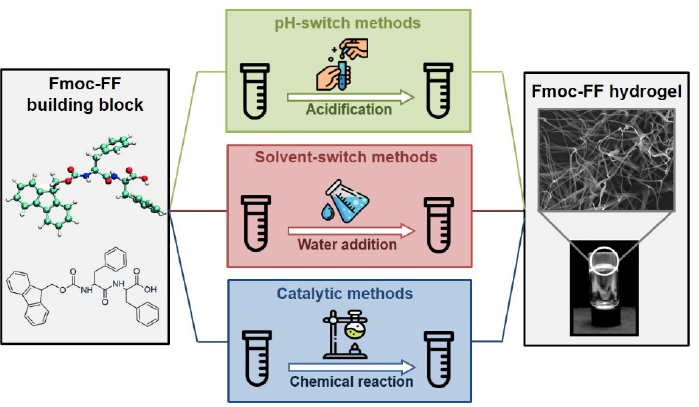
Figure 3. On the left, the molecular Fmoc-FF building block, reported both as 3D balls and sticks and as chemical formula. On the right, an inverted vial containing Fmoc-FF self-supporting gel and its TEM image. In the middle a schematic representation of three different methods (pH-switch, solvent switch, and catalytic one) commonly used for trigger gelation process.